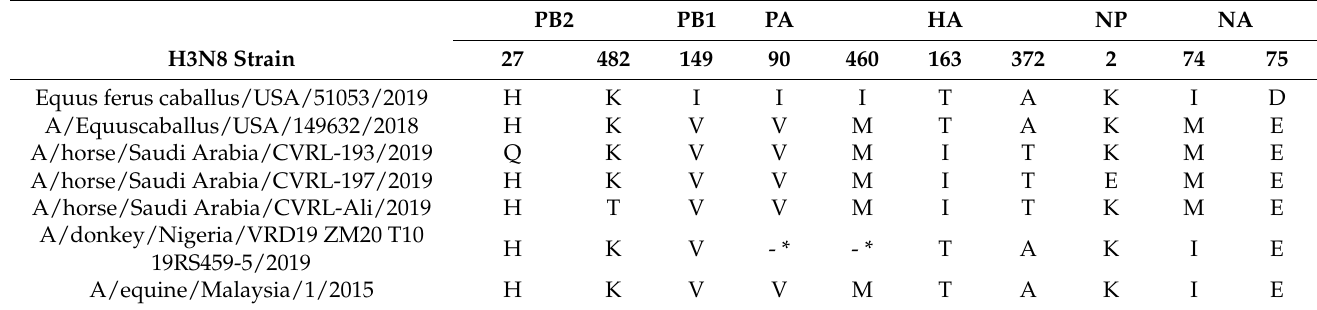
Both M and NS segments were not included in the comparison since they showed identical amino acid sequences to the Equus ferus caballus/USA/51053/2019. * Dashes mean sequences are not available. Both A/equine/Ohio/1/2003 and the A/equine/South Africa/4/2003 showed 10 amino acid substitutions in the HA1 (N6S, D7G, P47S, K62R, D63N, N104D, S138A, I163T, T188N, I2003V) and three in HA2 (R450K, L454Q, and N474D). A/equine/Richmond/1/2007 showed 12 amino acid substitutions in the HA1 (N6S, D7N, P47S, K62R, D63N,